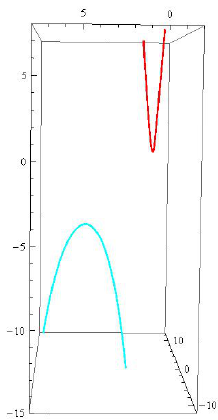
Figure 1. The red (blue) curve is the generalized T ( B ) -associate curve b 1 ( b 2 ) of r .